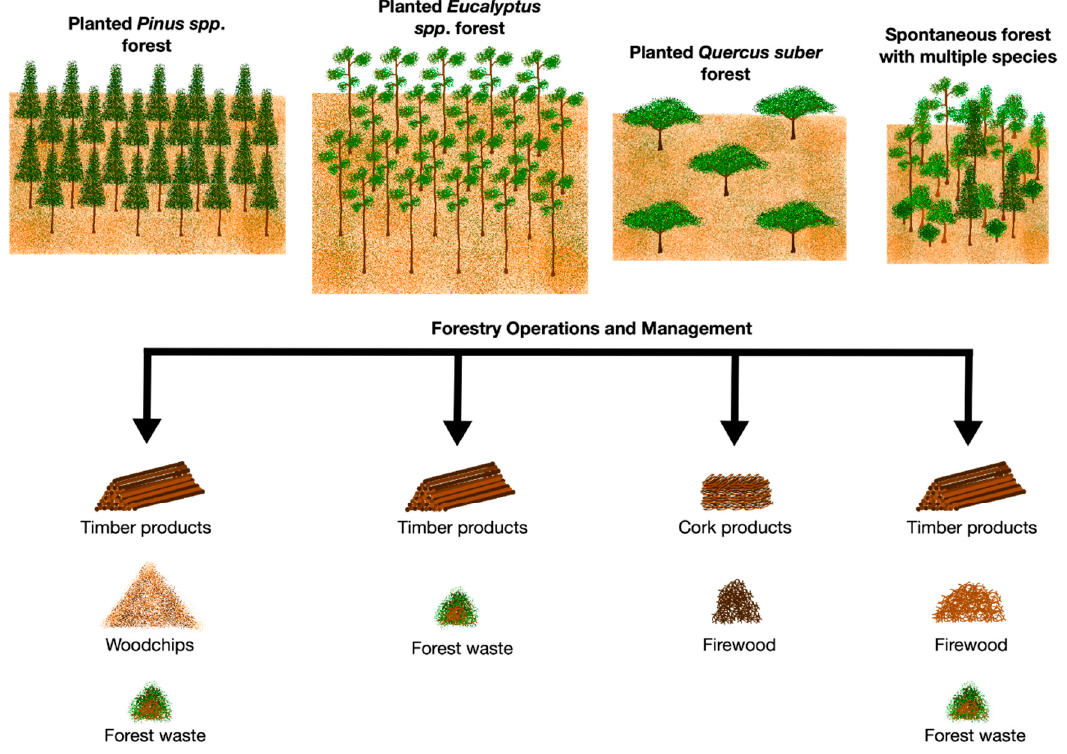
Figure 8. Different types of forest species also provide different types of products. However, in some cases, the products supplied are similar, varying only in quantity and quality. For this reason, the potential economic value varies with the choice made for afforestation.